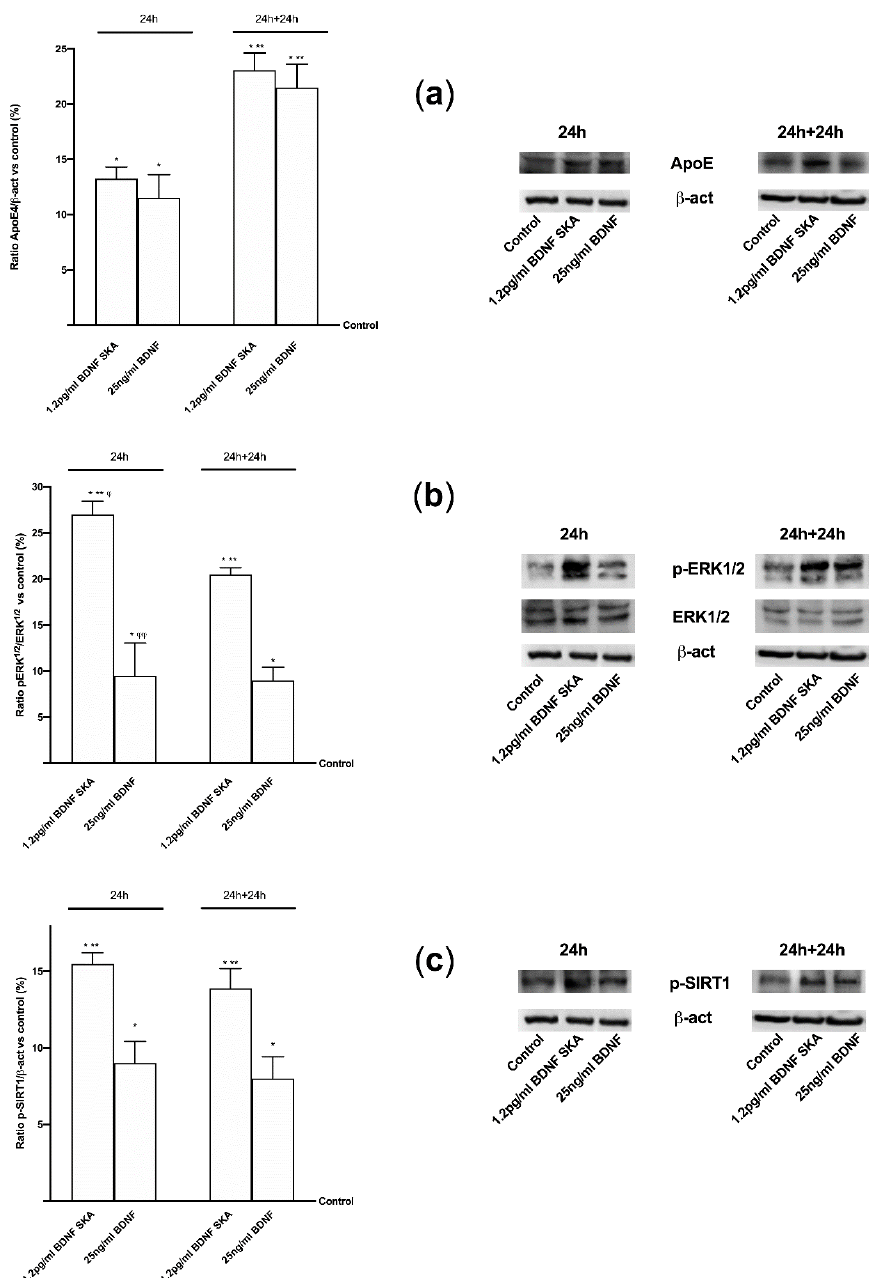
Figure 10. Western blot and densitometric analysis of ApoE ( a ), ERK / MAPK ( b , c ) SIRT1 expressions in brain tissue. In the left column densitometric analysis and in the right the examples of Western blot are reported. Each graph contains on the left the results obtained at 24 h (12 animals) and on the right (12 animals) at 24 h plus 24 h (24 h + 24 h). Data are expressed as means ± SD (%) of independent experiments normalized on specific total protein if possible and verified by β -actin detection. * p < 0.05 vs. control; ** p < 0.05 vs. 25 ng / mL BDNF at the same time of administration; ϕ p < 0.05 vs. 1.2 pg / mL BDNF SKA between 24 h and 24 h plus 24 h; ϕϕ p < 0.05 vs. 25 ng / mL BDNF between 24 h and 24 h plus 24